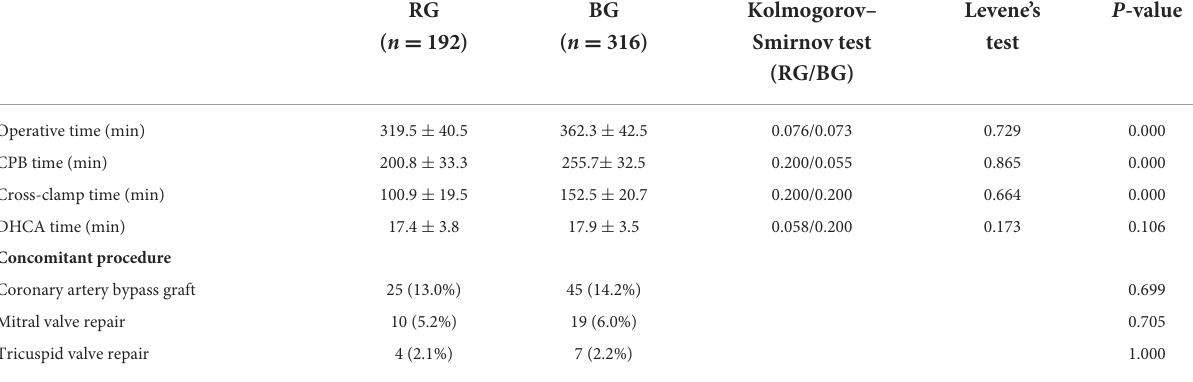
TABLE 2 Operative details of and concomitant procedures performed for the